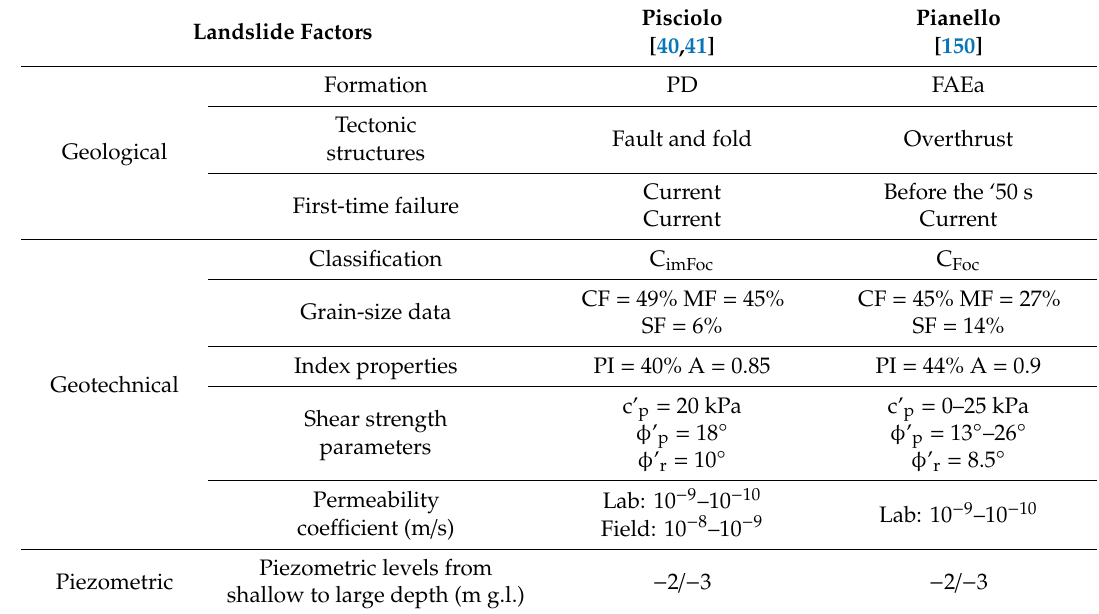
Table 7. Landslide factors for deep rototranslational landslides (class 5; Figure 11; [40,150]); for the geotechnical parameters referring to Tables 3 and